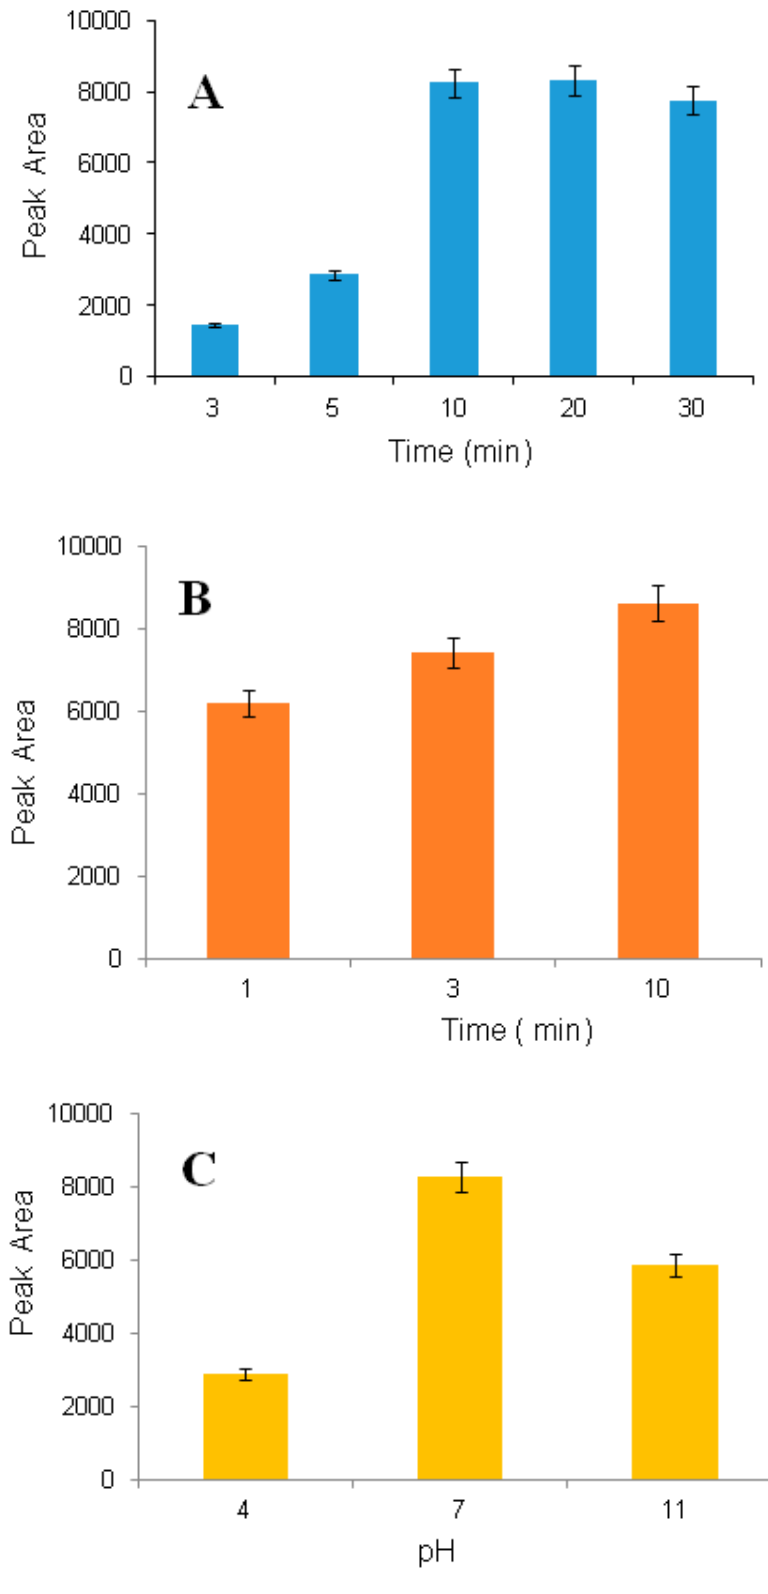
Figure 3. Effect of extraction time on extraction recovery (saliva sample, 1600 nmol L − 1 ) ( A ), effect of desorption time on extraction recovery (saliva sample, 1600 nmol L − 1 ) ( B ) and effect of sample pH (saliva sample, 1600 nmol L − 1 ) ( C ); pH was adjusted by addition of ammonium hydroxide and formic acid.